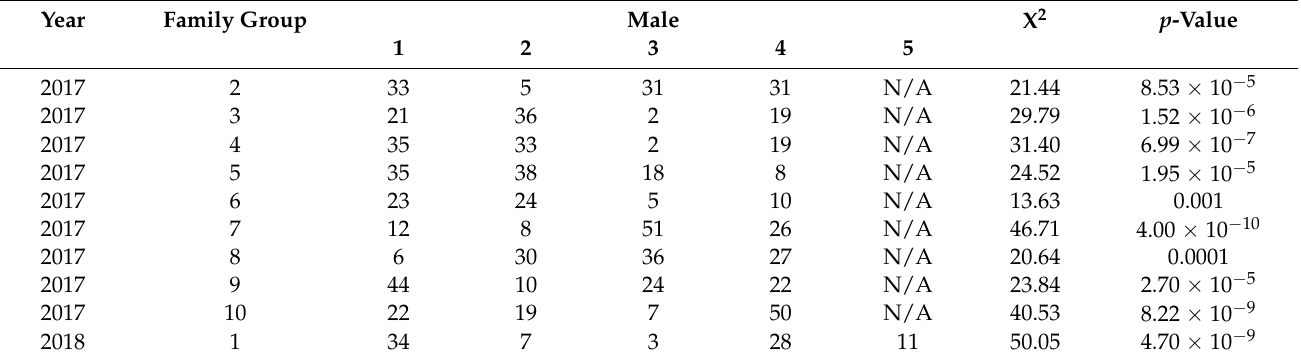
Table 1. Number of offspring produced by each male in 2017 and 2018 for the Ontonagon River stocking project. Four males were used for each family group in 2017 and five males were used in 2018. One female was used for each family group, with different males and females used for each family